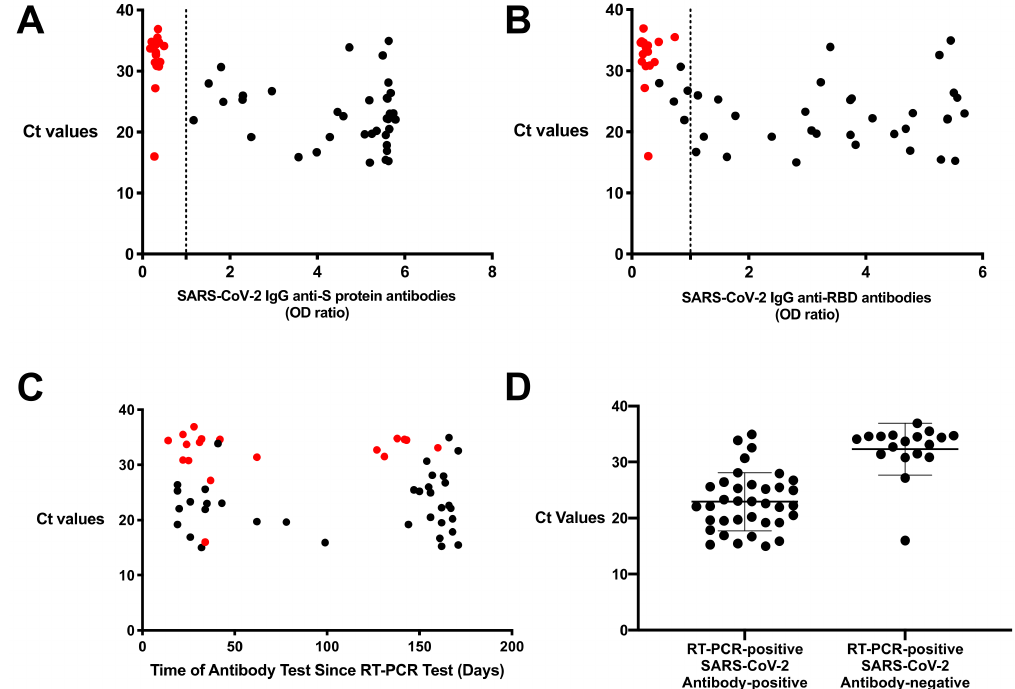
Figure 1. Ct values were variable in resolved subjects who test SARS-CoV-2 antibody negative or positive. Ct values of a subset of resolved subjects ( n = 54) were compared to their corresponding SARS-CoV-2 ( A ) anti-S protein IgG and ( B ) anti- receptor-binding domain (RBD) IgG. ( C ) Ct values were then compared to the subjects’ respective time since initial RT-PCR test. ( D ) Ct values for RT-PCR-positive in antibody-positive and antibody-negative were compared. Values are shown as a ratio of observed optical density to the determined assay cut-off optical density or time since RT-PCR test until blood donation compared to absolute Ct values. Red circles indicate resolved samples who were